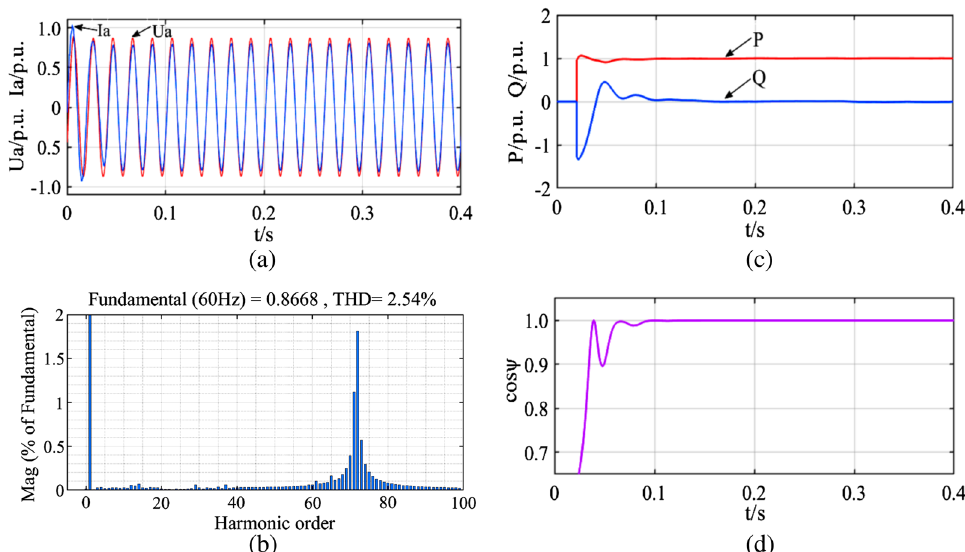
Fig. 15 A-phase waveforms of inverter with FCS-MPCC under initial condition a A-phase voltage and current at PCC, b harmonic analysis of A-phase grid current, c active and reactive power into power grid, d power